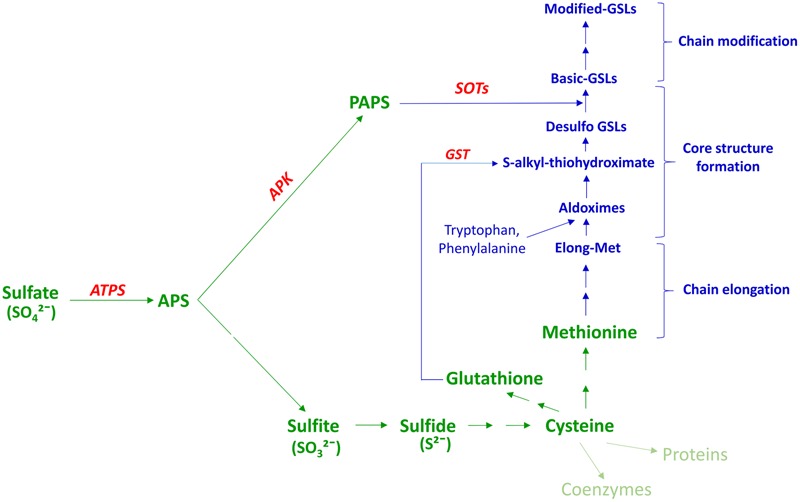
Association between plant S assimilation and GSL biosynthesis. Modified from Sonderby et al. (2010); Mugford et al. (2011) PAPS, 3′-phosphoadenosine 5′-phosphosulfate; APS, adenosine 5′-phosphosulphate; ATPS, ATP sulfurylase; APK, APS kinase; GSL, glucosinolate; GST, glutathione -S-transferase; SOT, sulfotransferase. Text in green indicates the S-assimilation process, and text in blue GSL biosynthesis. Enzymes are shown in red.